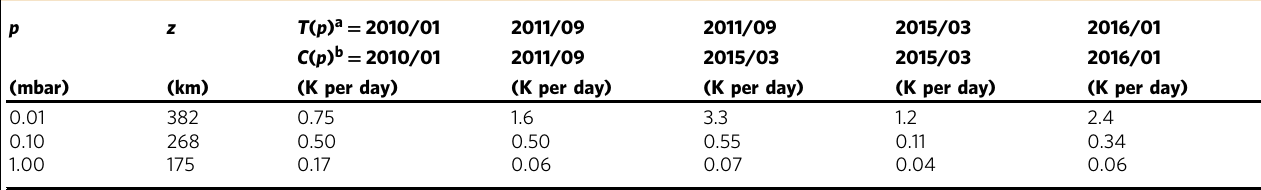
Table 1 Cooling rates for measured atmospheric pro fi les